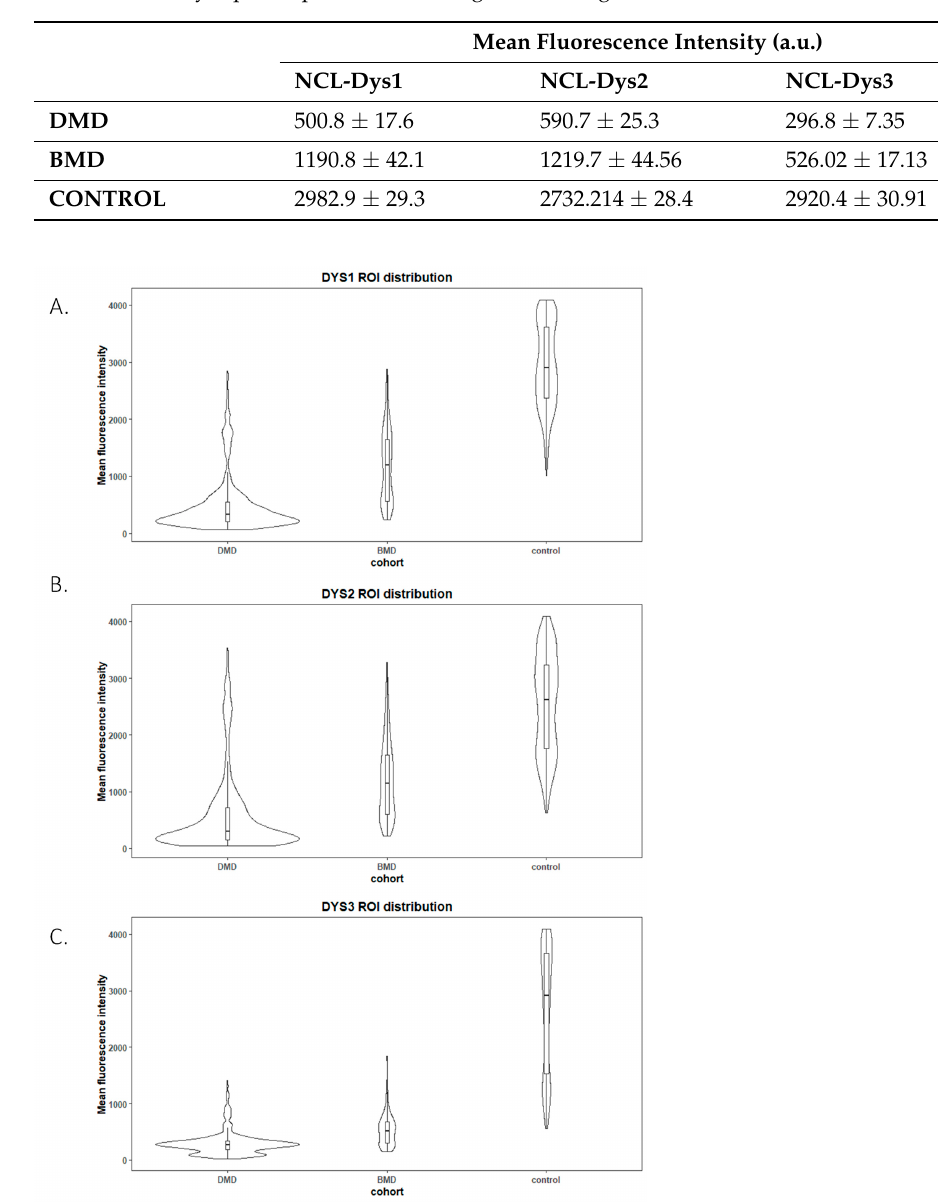
Table 1. Dystrophin mean fluorescence intensities (a.u.) and standard errors obtained from the 78 ROI of all patients for each pathological group: DMD, BMD and healthy controls. Fluorescent intensities for each antibody separate patients according to their diagnosis.